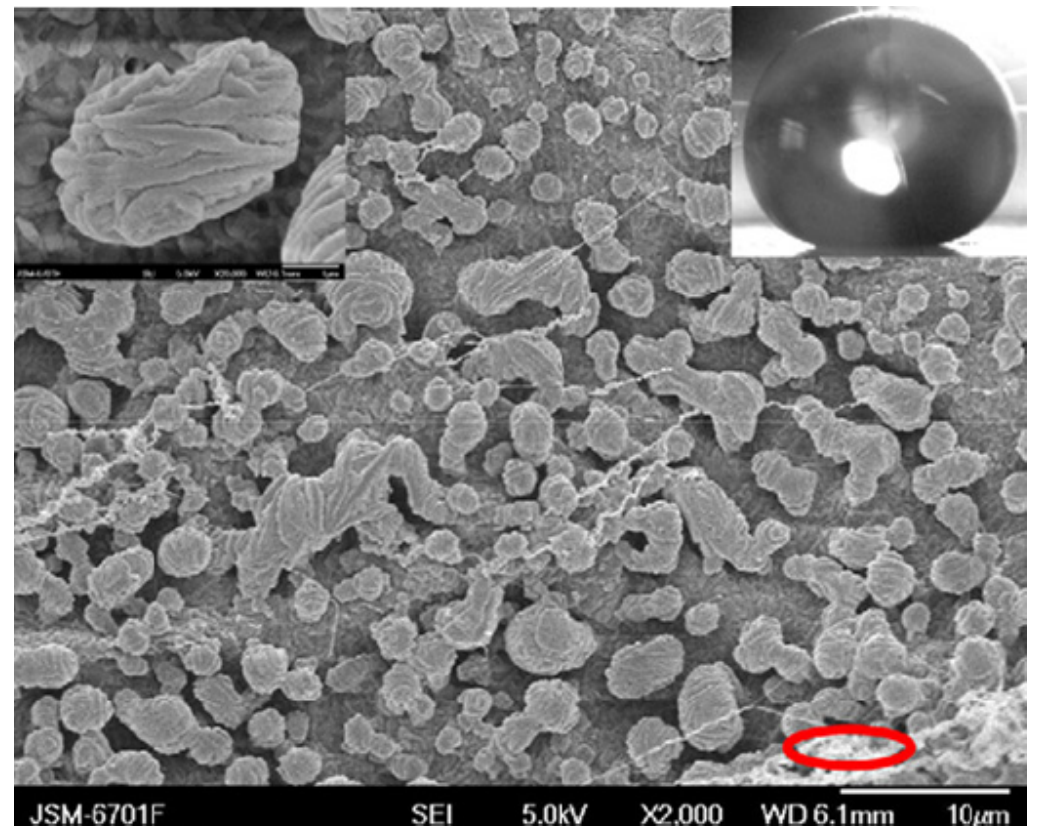
shows single papillae with rough morphology and right inset shows the spherical water drop on the surface with contact angle of 162 ± 2°). Images reprinted from [111], with permission from Elsevier, Copyright